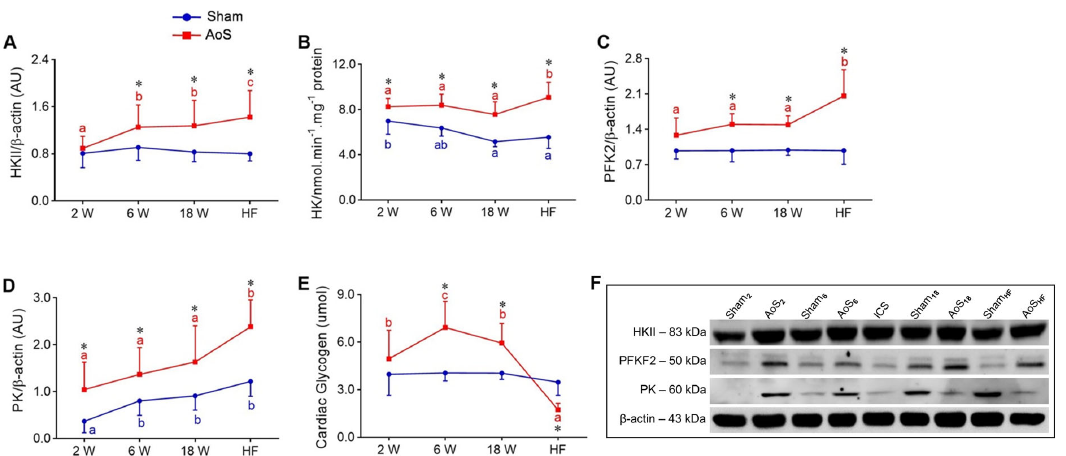
Figure 7. Myocardial glycolysis and glycogen at different moments of euthanasia (2, 6, 18 weeks [W] and heart failure [HF]) evaluated by Western blot and enzymatic activity assay. Sham: operated control (blue); AoS: supravalvar aortic stenosis (red). Quantification of ( A ) HKII: hexokinase II, ( B ): HK: activity of hexokinase II, ( C ) PFKB2: phosphofruct kinase 2, ( D ) PK: pyruvate kinase, and ( E ): cardiac glycogen. ( F ) Representative bands of proteins. Data are expressed as mean ± SD and analyzed by ANOVA and Tukey. p < 0.05. * AoS vs. respective Sham. Distinct letters signify statistical difference between moments; ( n = 8 animals for each group).